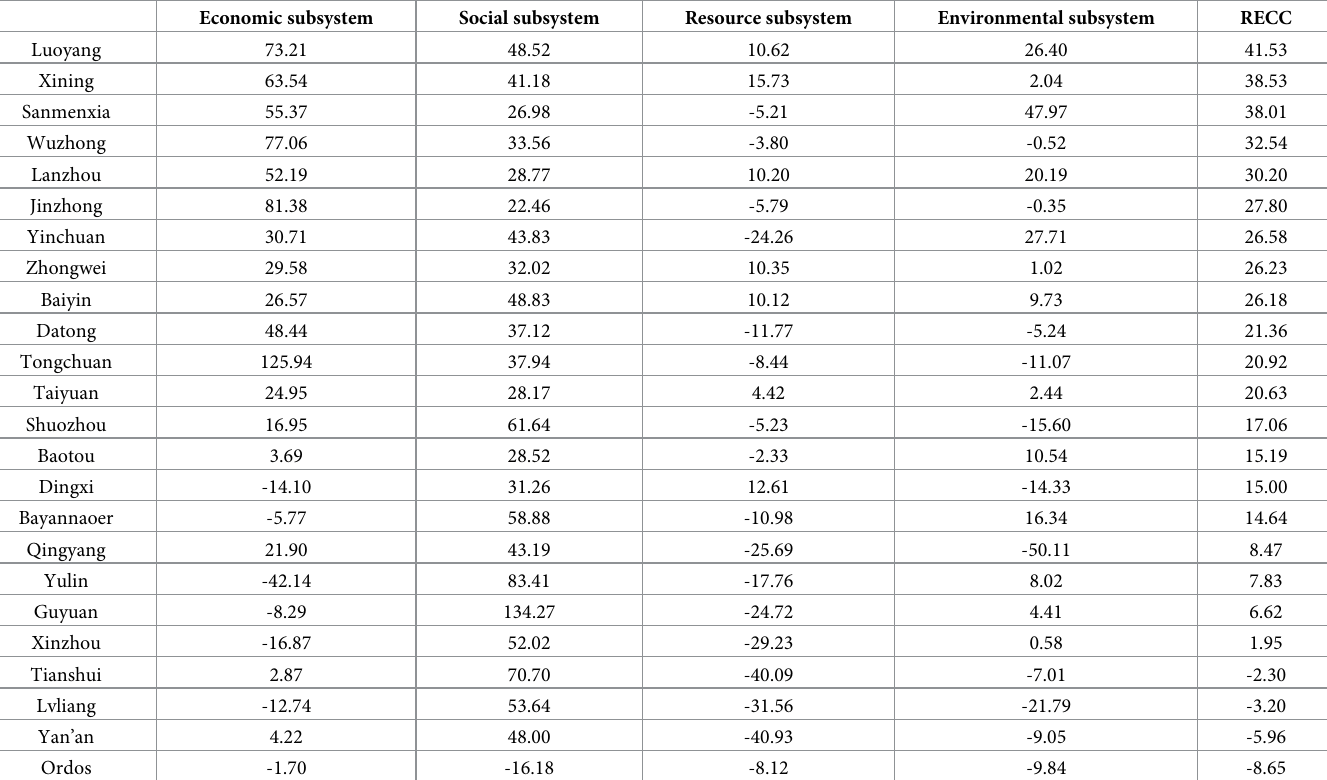
Table 3. The growth rate of the carrying capacity of each subsystem in 24 cities from 2013 to 2018